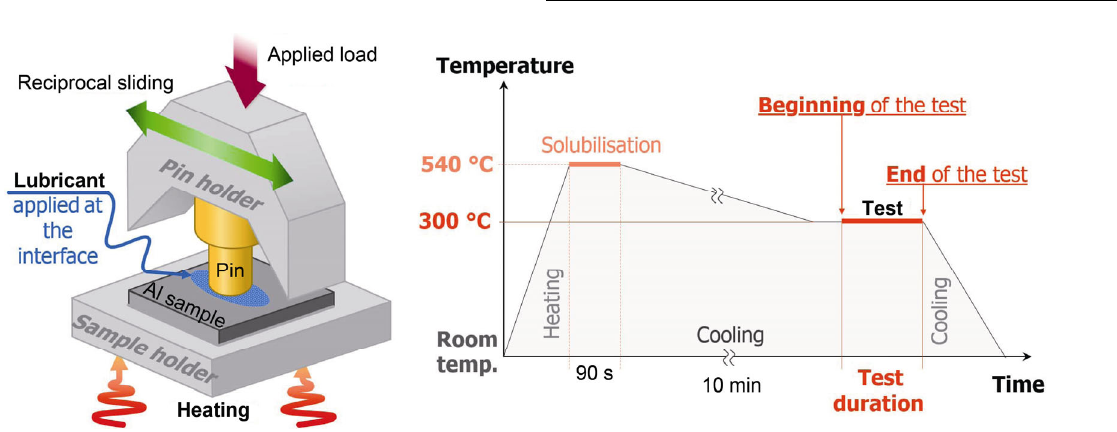
Fig. 4 Sketch of the SRV ® test set-up and the heat cycle (not to scale) applied to the aluminium specimen